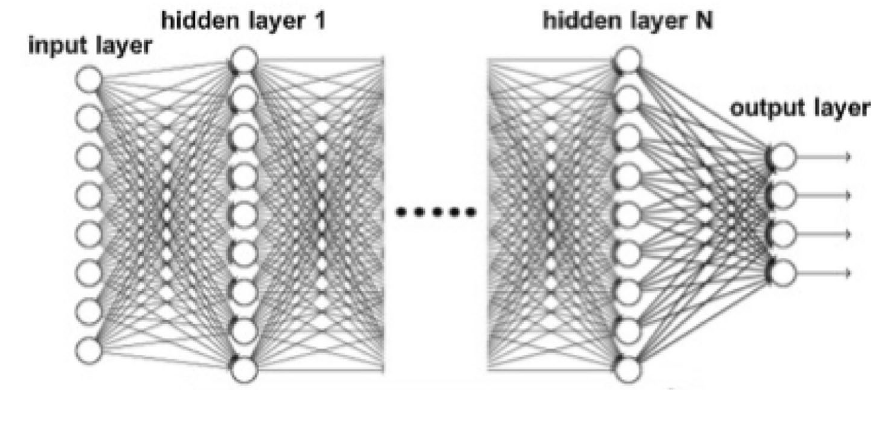
Fig. 4 Actual vs predicted value for neural networks without cross validation (cross valida- tion not considered as part of the model formulation) with a wetting phase relative perme- ability for validation set, b wetting phase relative perme- ability for test set, c non-wetting relative permeability for valida- tion set, d non-wetting relative permeability for the test